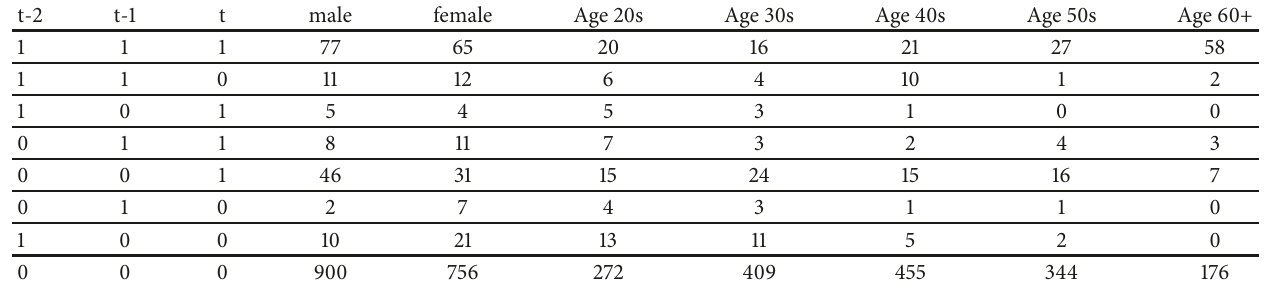
Table 5: Nonmotor mode use status over time from (t-2) to